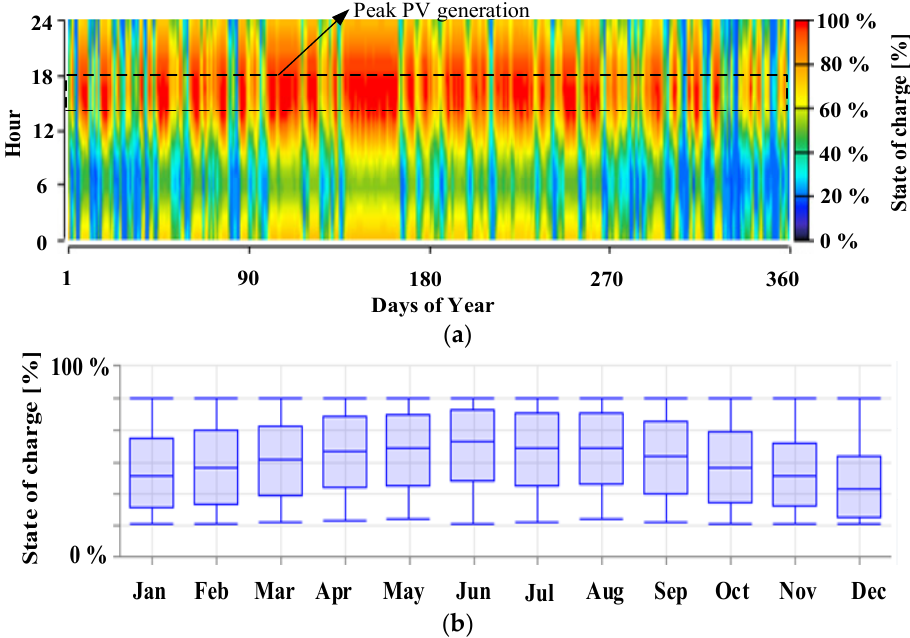
Figure 10. The ESS state of charge: ( a ) in hourly scale; ( b ) in monthly scale.